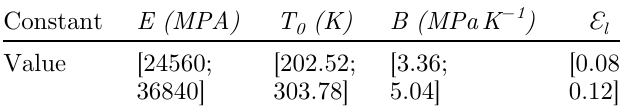
Table 2. Characteristic of uncertain